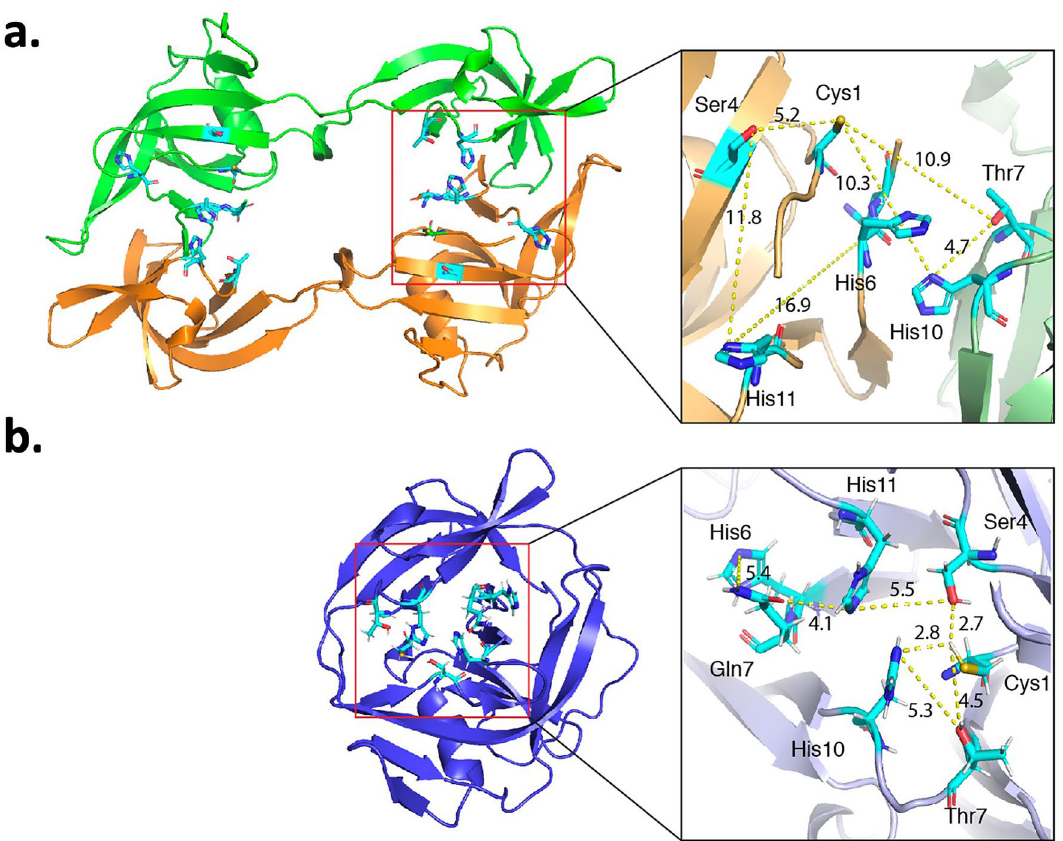
Figure 7. Active site organization of the Pho PolII and Pab PolII inteins. Distance between key residues in the active site of ( a ) the Pho PolII intein domain swapped dimer (PDB code 5BKH) and ( b ) the Pab PolII intein NMR structure for the solution closest to the mean of the NMR ensemble (PDB 2LCJ). Cys1 is in intein block A and is the nucleophile in step 1 of splicing. Thr7 and His10 of intein block B help to catalyze step 1 of splicing. Gln7 of block G is the ultimate intein residue that is cyclized in step three of splicing; this step is catalyzed by the penultimate block G His and the conserved His11 of block F. Residue Ser4 of block F helps to coordinate the steps of splicing. Figure was made with PyMOL 2.4.0.